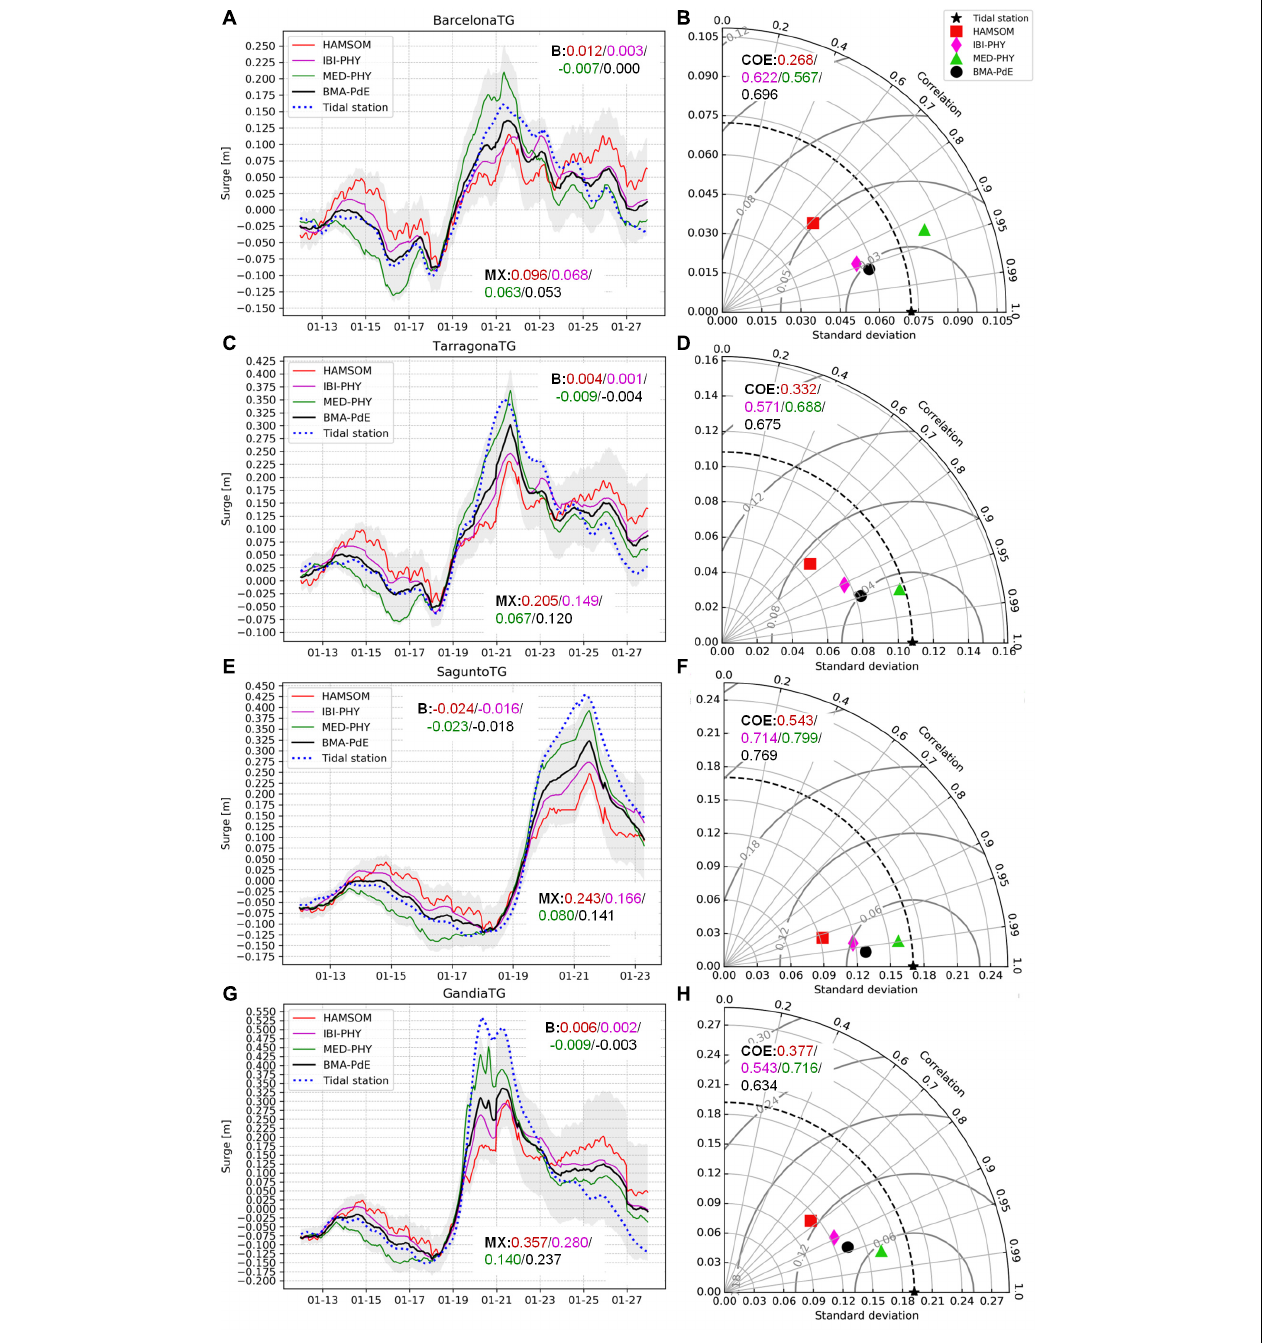
FIGURE 9 | Results of the ENSURF system at several TGs during the storm Gloria: Nivmar (red), IBI-MFS (magenta), MedFS (green), BMA-PdE (black), and observations (blue). Left: surge time series at Barcelona (A) , Tarragona (C) , Sagunto (E) , and Gandía (G) . B is the mean bias for each model, in meters (same chromatic index). MX is the maximum error, in meters. The gray areas enclose the 5-95th percentiles of the ENSURF system. Right panels: Taylor diagrams at Barcelona (B) , Tarragona (D) , Sagunto (F) , and Gandía (H) . Legend: Nivmar (red square), IBI-MFS (magenta rhombi), MedFS (green triangle), BMA (black dot). COE is the Coefficient of Efficiency for each model (dimensional).